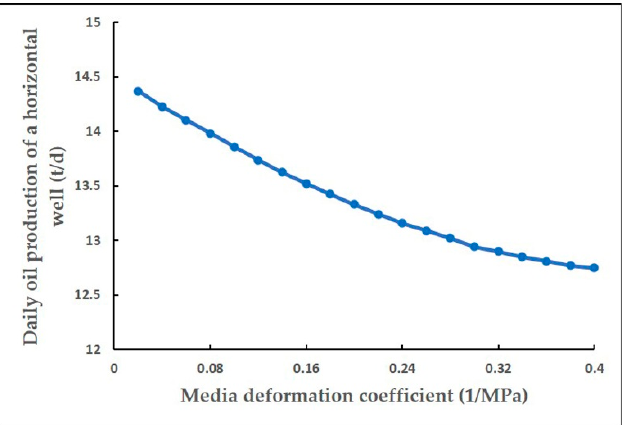
Figure 11. The influence of media deformation coefficient on horizontal well production.